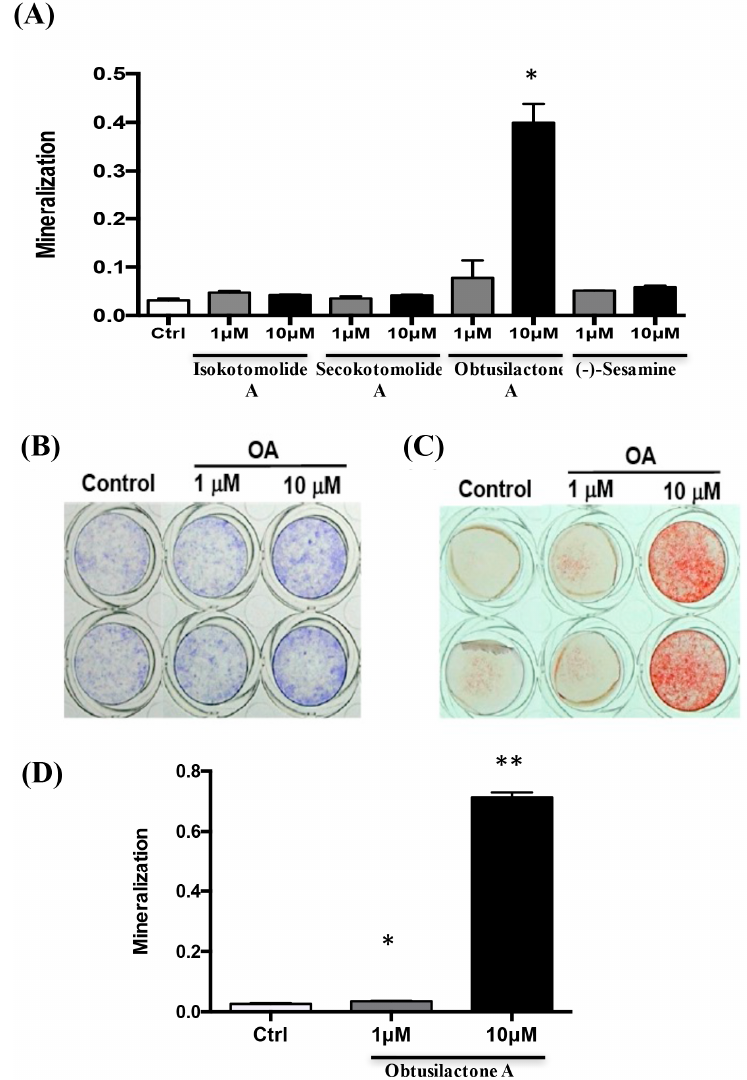
Figure 2. Obtusilactone A induced osteogenic differentiation of BMSCs: ( A ) pre-screening of the mineralization stimulatory ability of the natural pure compounds extracted from C. kotoense in BMSCs based on a mineralization assay; ( B ) determination of the ALP activity of BMSCs after treatment with 0.01% DMSO (control) or 1 and 10 µ M OA for three days; ( C ) mineralization assay of BMSCs after OA treatment; and ( D ) quantified results of the mineralization assay. Data are presented as the mean of three independent experiments. The data shown are the means ± SD of 3 independent experiments. *